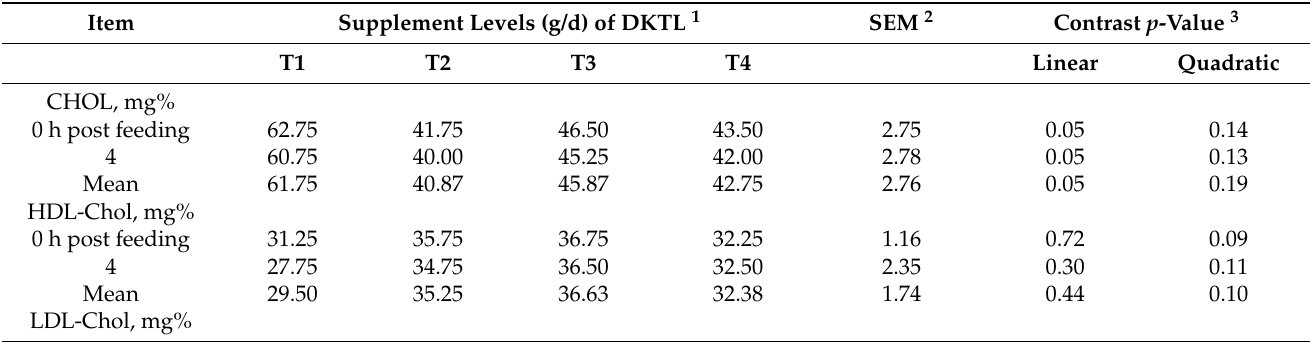
Table 6. Effects of supplement levels (g/d) of dried kratom leaves on lipid profile in